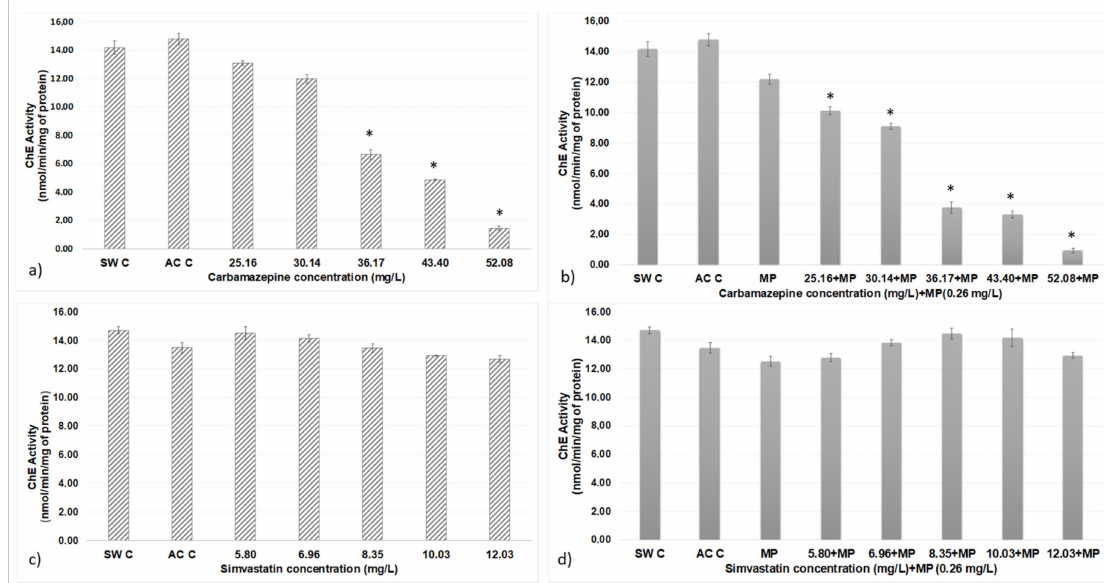
Figure 4. ChE activity of A. salina after 48 h of exposure to different contaminant concentrations: ( a ) simvastatin, ( b ) sim- vastatin + MP, ( c ) carbamazepine and ( d ) carbamazepine + MP. Error bars represent standard deviations. * Significantly different between controls and other treatments ( p >